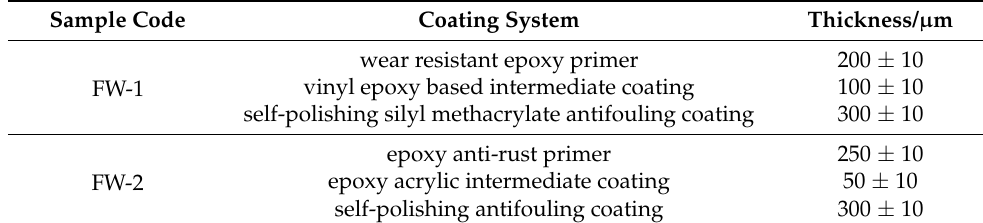
Table 1. Coating systems prepared and the film